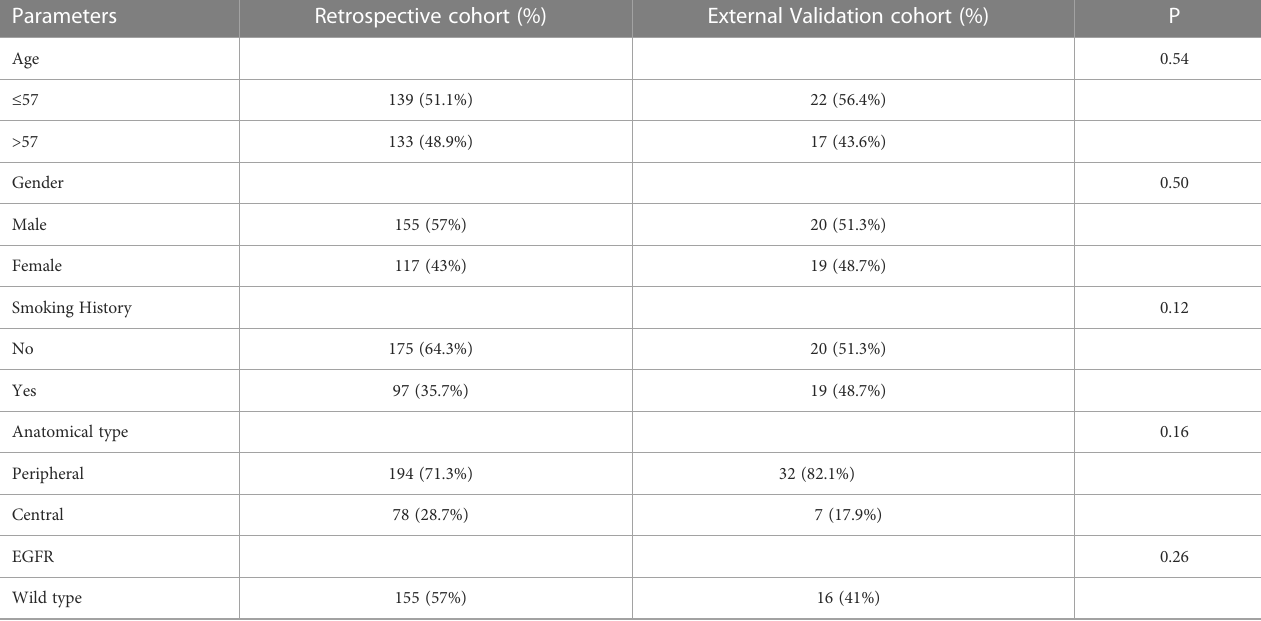
TABLE 3 Comparison of baseline characteristics of patients in retrospective and external validation cohort.